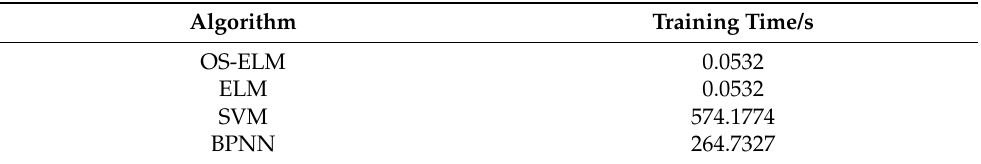
Table 2. Comparison of the training time of the four